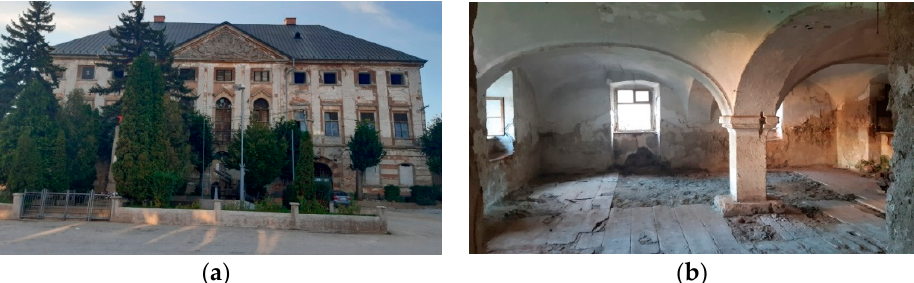
Figure 6. ( a ) Coburg manor house on Republic Square in Jelšava and ( b ) interior of the building of the Evangelical School at the Evangelical Church in Jelšava.